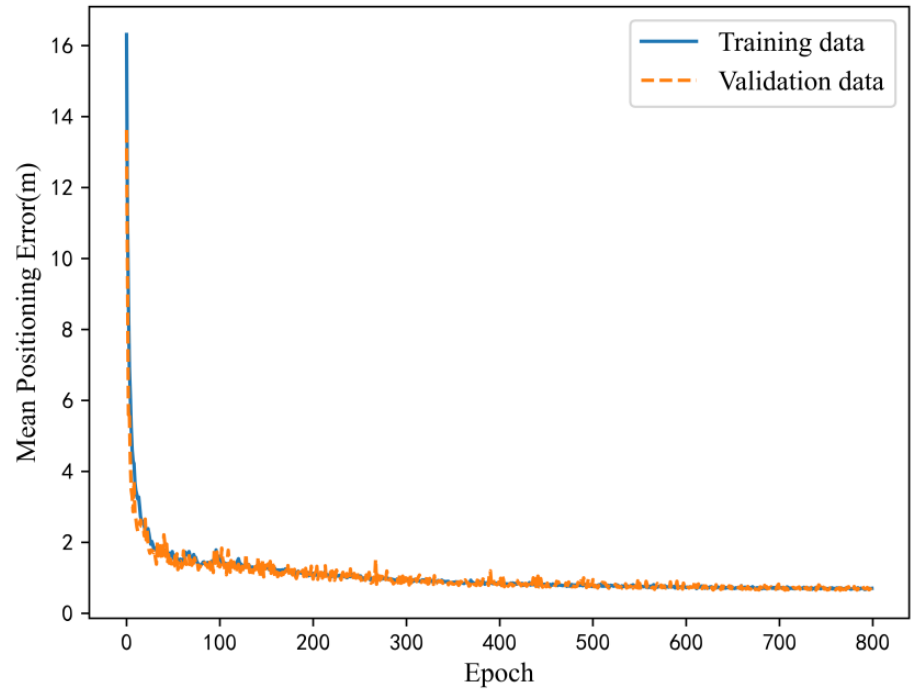
Figure 11. Variation curve of loss function in training process.